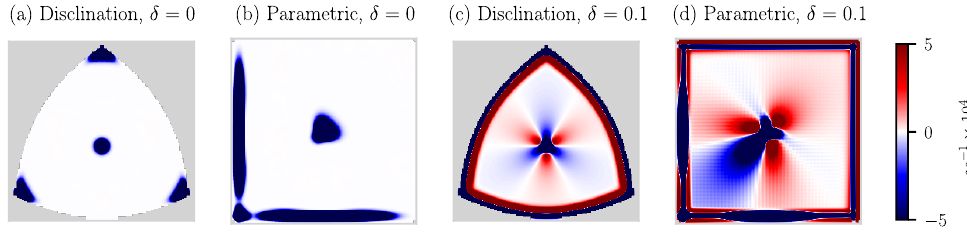
Figure 3: Local charge density at half-filling in the defects. A defect displaces both negative (blue) and positive (red) excess charge in the absence of sublattice sym- metry, resulting in a divergent defect charge. (a-b) The parametric defect and the disclination with sublattice symmetry. (c-d) The parametric defect and the disclina- tion without sublattice